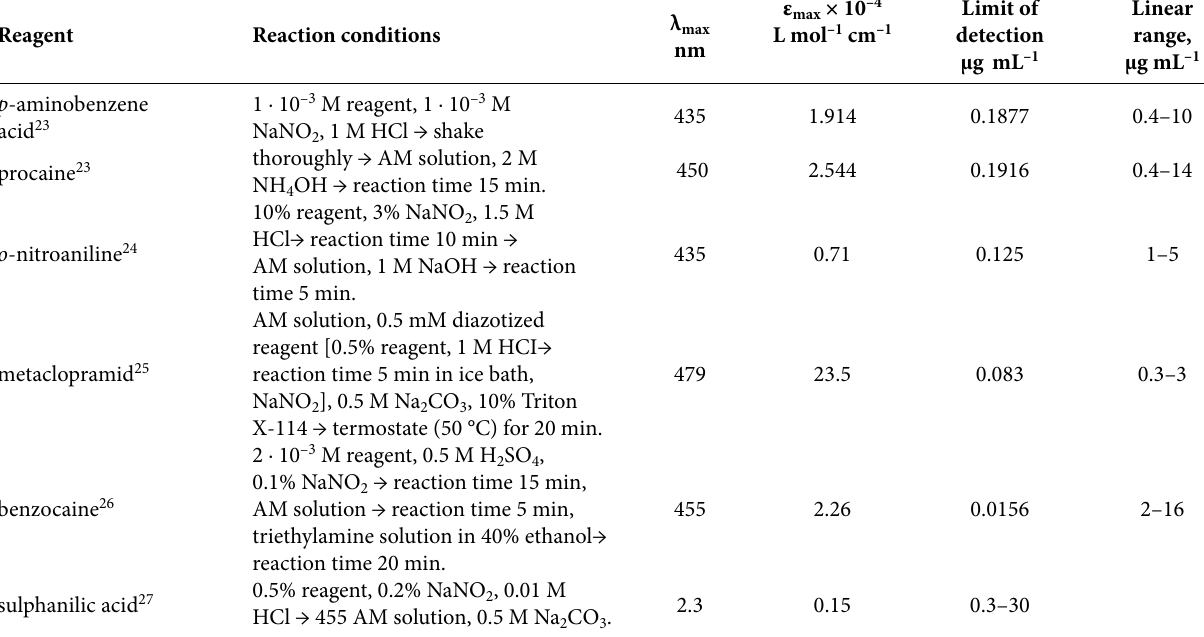
Table 4. Spectrophotometric methods for the AM determination using reaction of